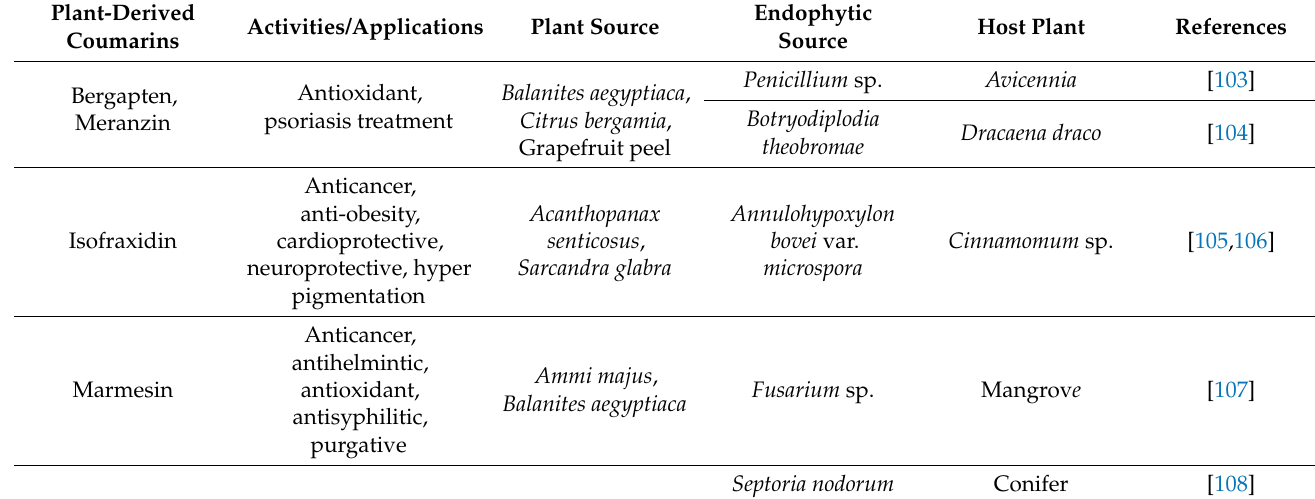
Table 2. Plant-derived coumarins produced by endophytic